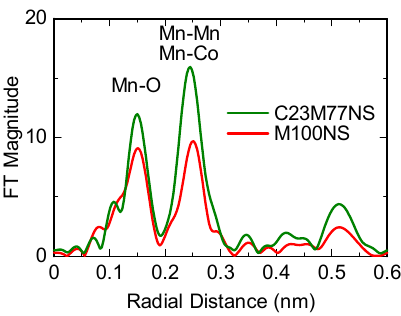
Figure 6. Fourier transforms (FTs) of the Mn K-edge extended X-ray absorption fine structure (EXAFS) spectra of restacked C23M77NS and M100NS.